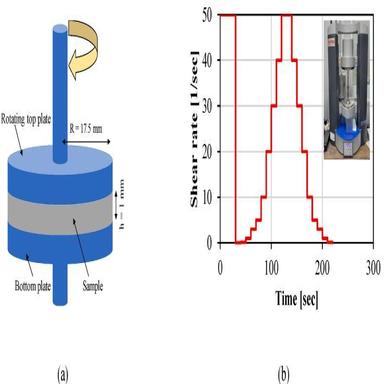
Rheometer test: (a) parallel plate geometry and (b) stepwise protocol for the measurement.